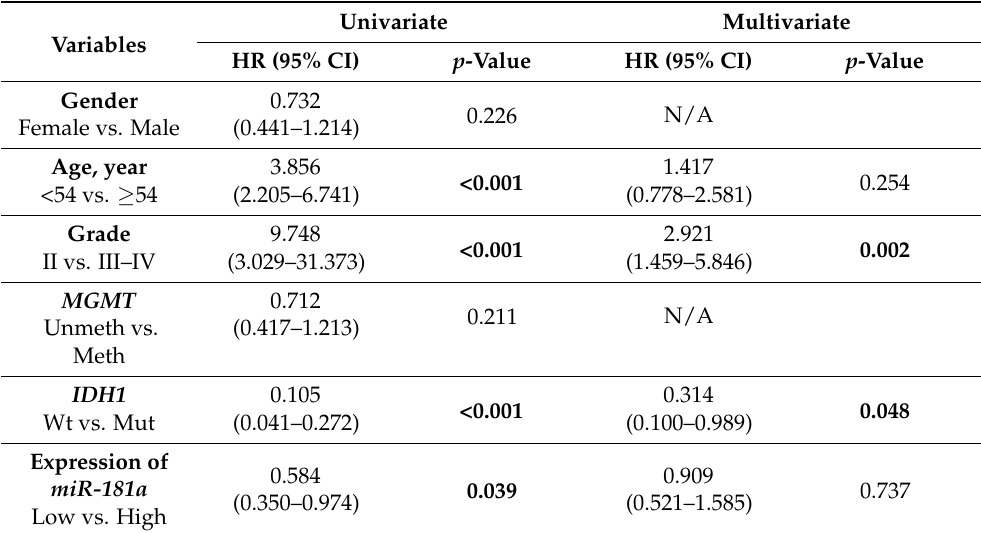
Figure 2. Statistically significant associations of miR-181a expression with patient ( a ) age; ( b ) IDH1 status; ( c ) tumor grade; ( d ) patient survival time. The boxplots indicate mean, within 25 and 75 percentiles, min, and max values. Green dots—grade II, blue—III, and red—IV (GBM). Student’s t -test, * p < 0.05, ** p < 0.01. Table 2. Univariate and multivariate Cox regression analysis of clinicopathological variables and expression of mir-181a